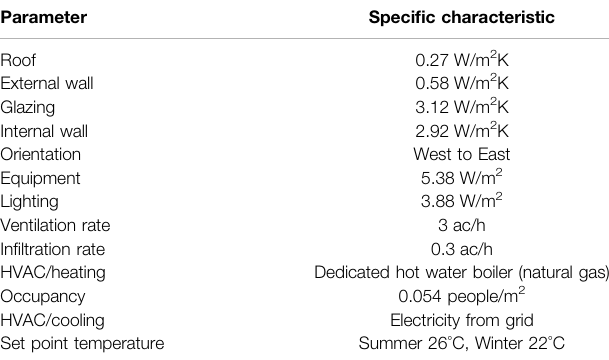
TABLE 3 | Construction speci fi cations of the selected apartment building (Kim et al., 2009; Jang et al., 2010; Jehean,